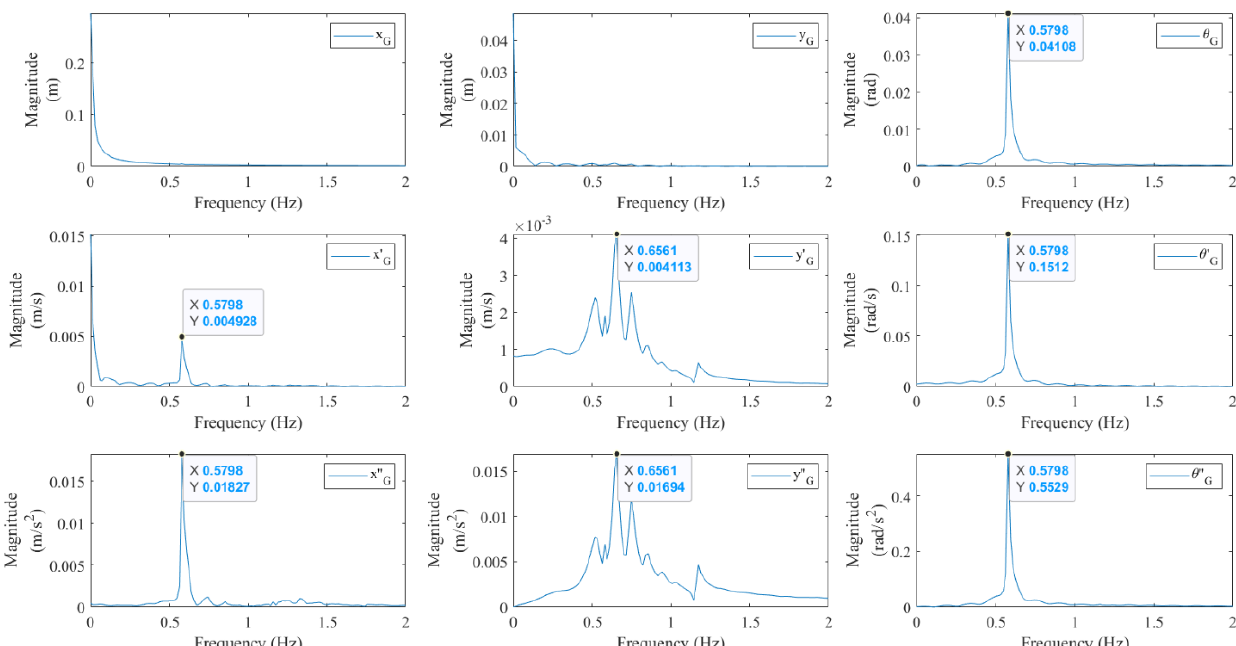
Figure 5. The angular displacement, velocity, and acceleration time histories of the floating body under free vibration at an initial 5° pitch.